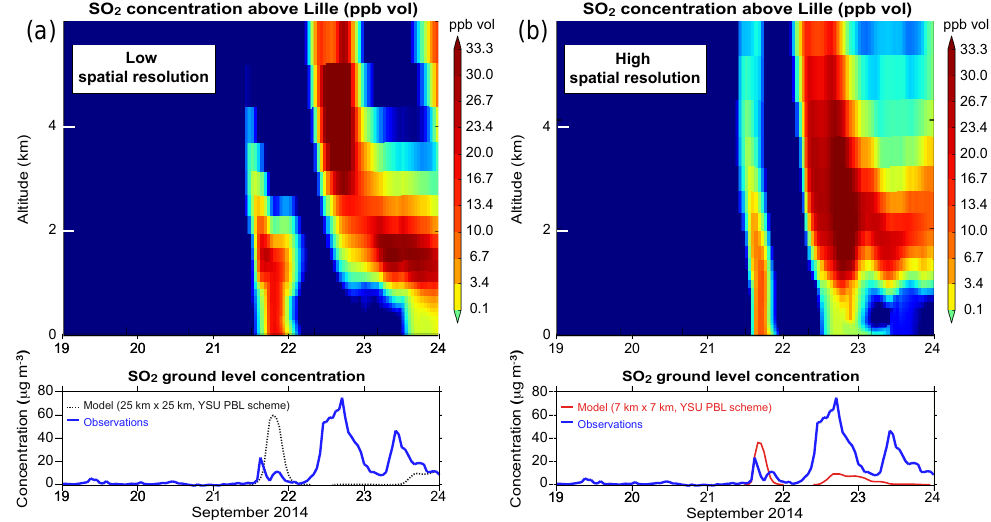
Figure 11. Comparison of far-range vertical distributions of SO 2 over Lille modelled with simulations at (left) low versus (right) high horizontal resolution (both configured with the YSU PBL parameterization scheme). Simulations at low resolution (25km × 25km) are performed on a single domain while simulations at higher resolution are performed on two nested domains: the largest with a coarse resolution of 22km × 22km and the narrowest with a fine resolution of 7.3km × 7.3km (Fig. 10). (Top) Modelled concentration of volcanic SO 2 over Lille as a function of time ( x axis) and altitude ( y axis). (Bottom) Time evolution of the observed (blue) and modelled (red or black) SO 2 concentrations at ground-level.